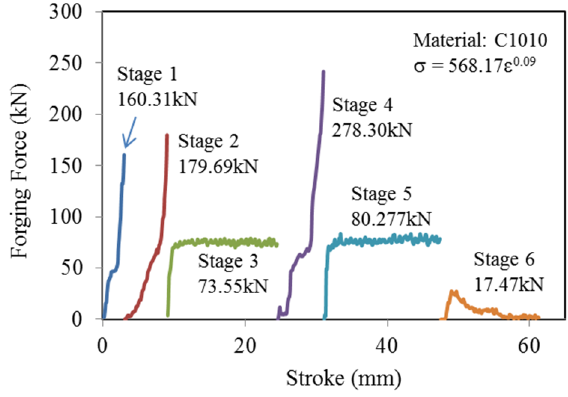
Figure 8. Forging loads of the six stages.